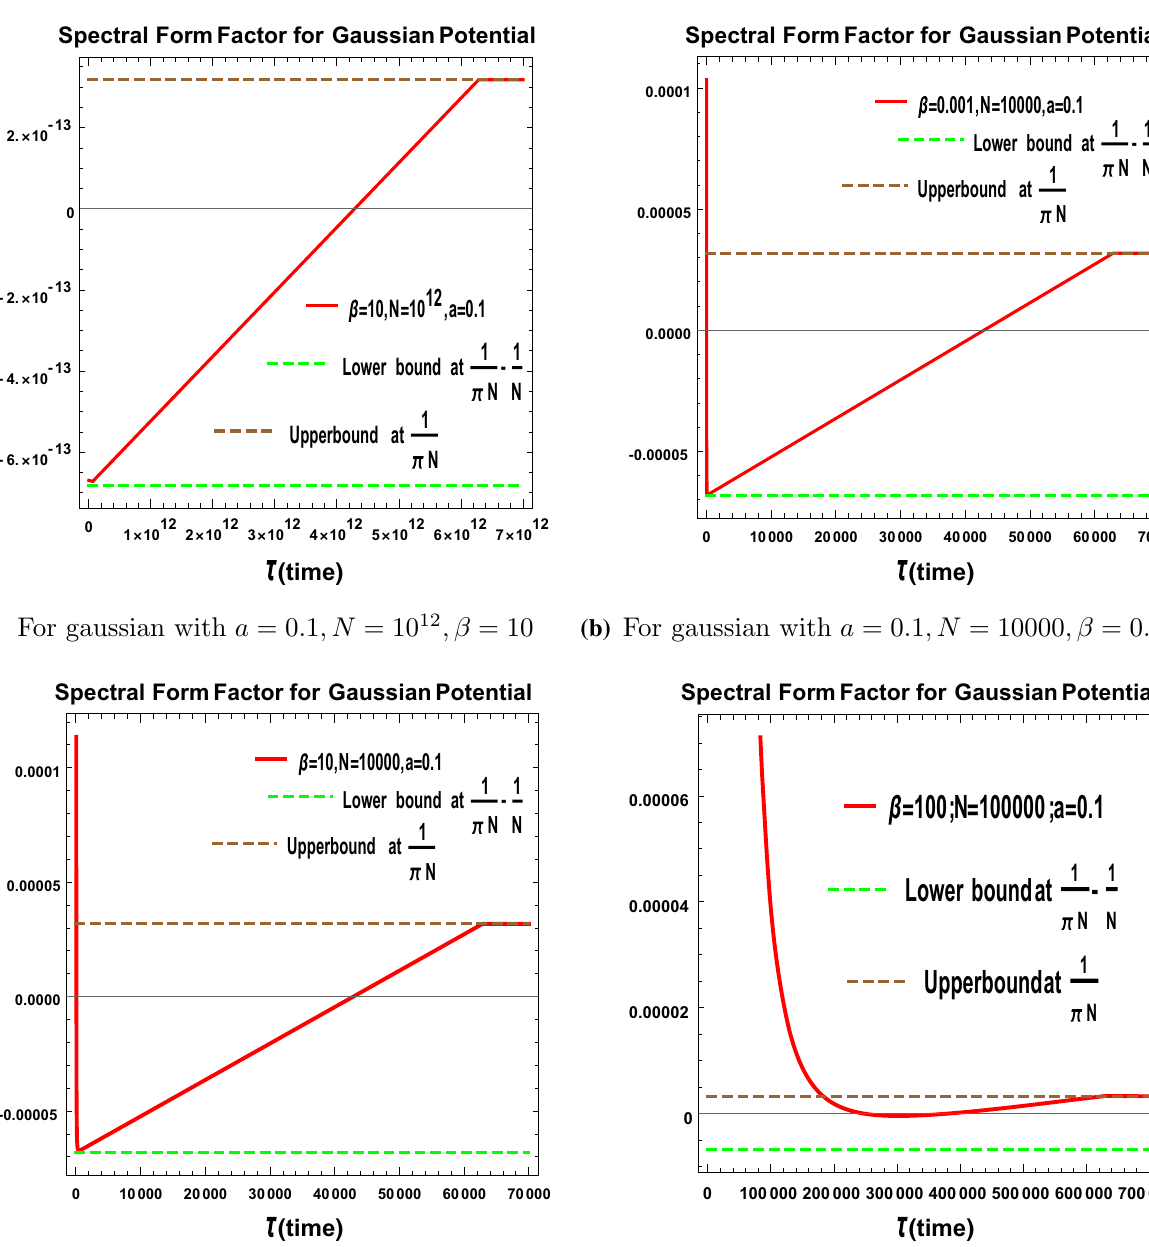
Fig. 35 Different nature of SFF at finite [ β (cid:9)= 0] and Infinite temperature [ β = 0]